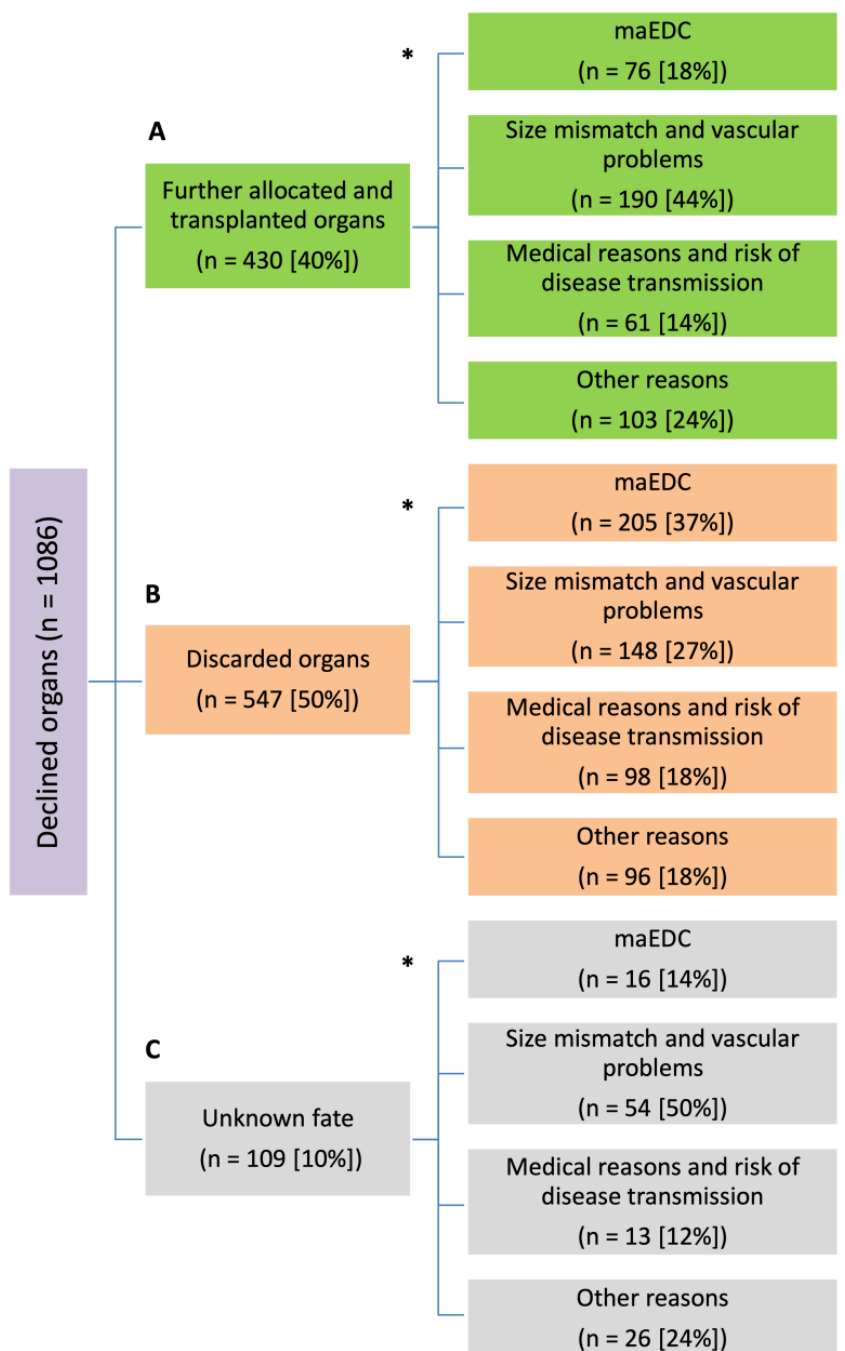
Figure 1. Flow diagram of declined organs (n = 1086). Fate of the declined organs (A–C) and reasons for declining an organ (*). maEDC, major extended donor criteria.